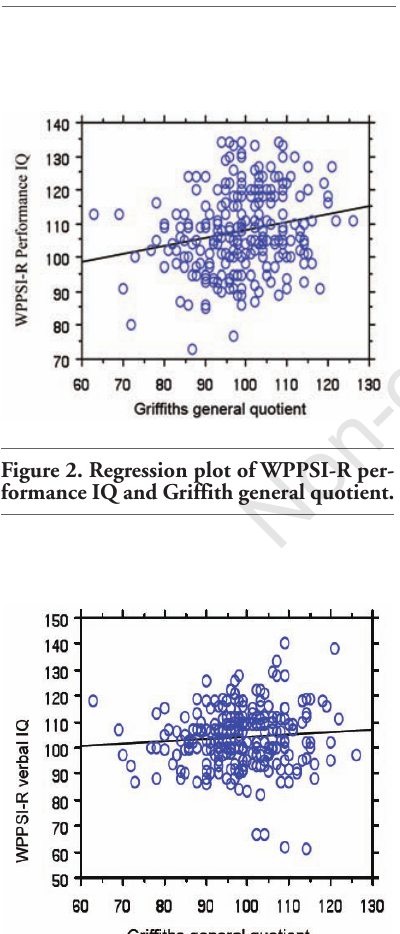
Figure 1. Regression Plot of WPPSI-R full scale IQ and Griffiths general quotient.